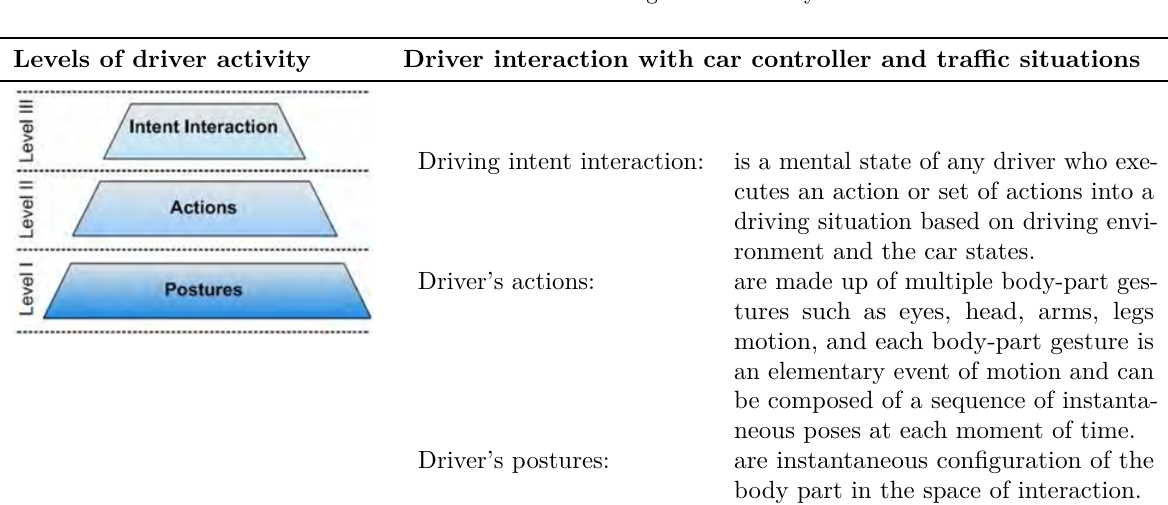
Figure 1. Architecture of the digital co-driver system.